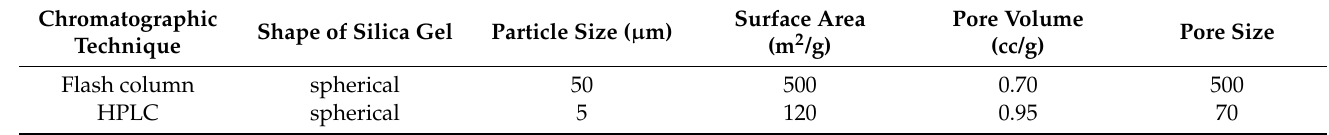
Table 1. Chromatographic silica specifications for flash column chromatography and HPLC.